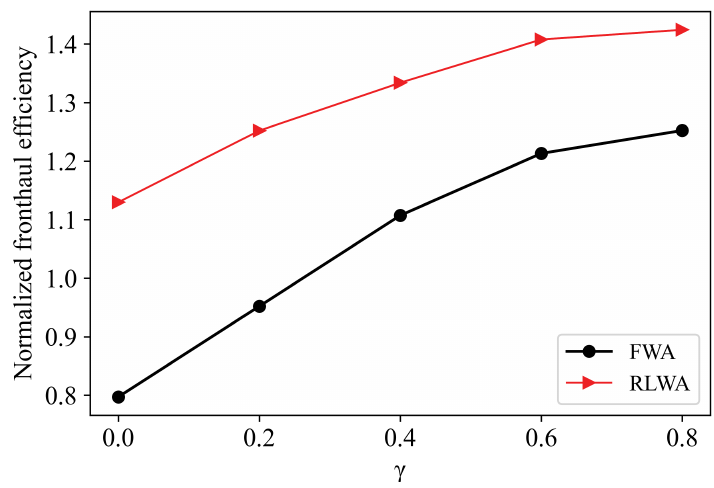
Figure 8. Impact of γ on fronthaul efficiency.